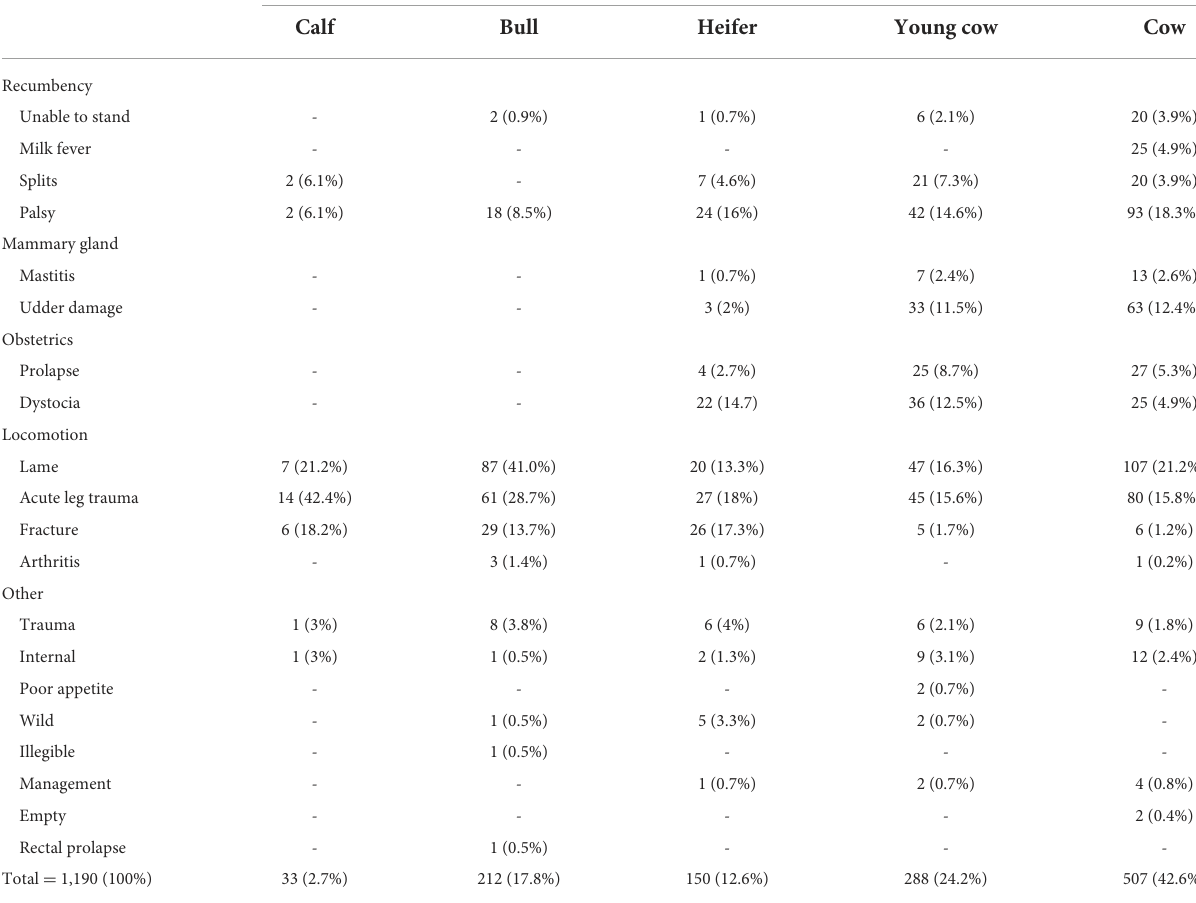
TABLE 4 Descriptive table showing number and percentage of total of each animal type within each subcategory of OFES, n = 1,190, only including animals from a dairy production system. Causes Animal type Calf Bull Heifer Young cow